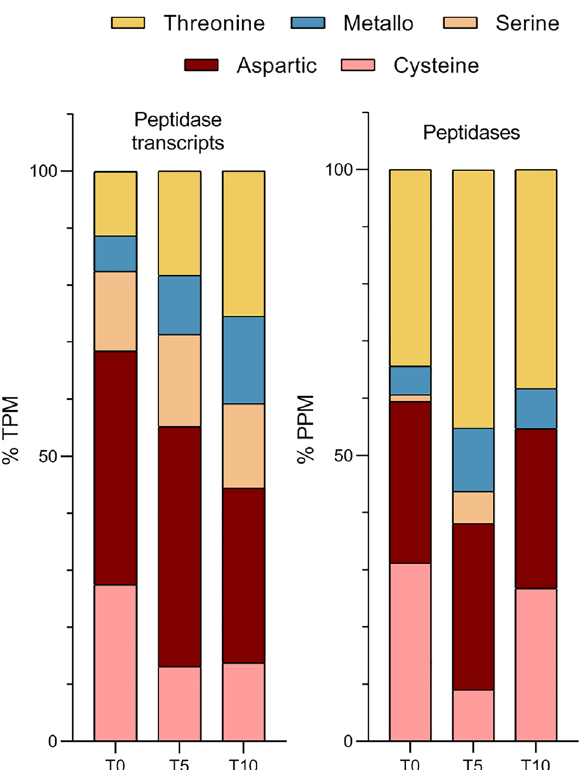
Figure 4. Representation of individual catalytic classes among the transcribed/translated peptidases. Percentages were counted based on relative abundance values in